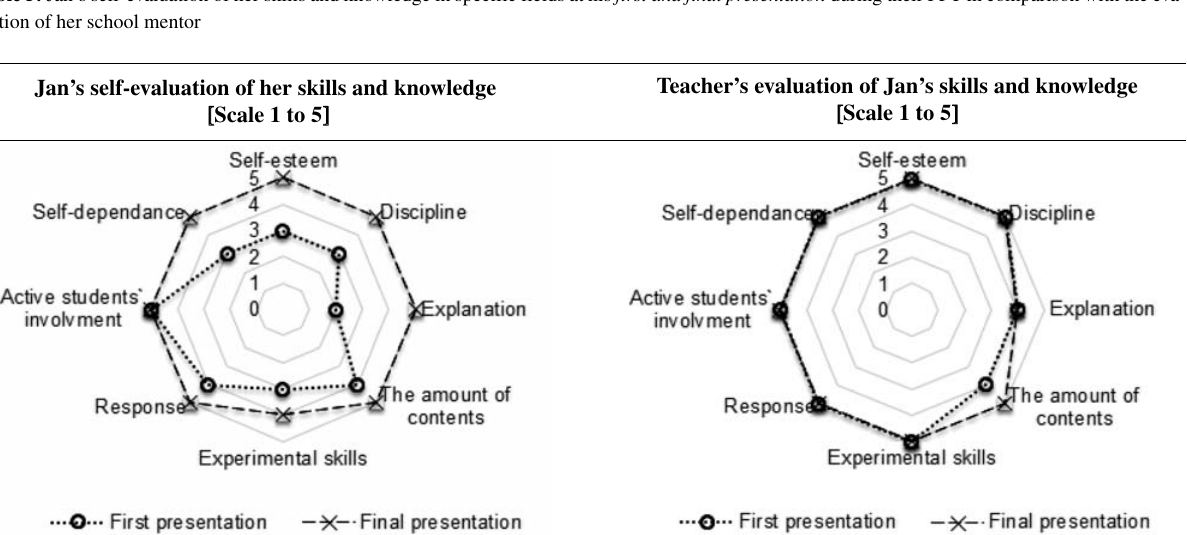
luation of her school